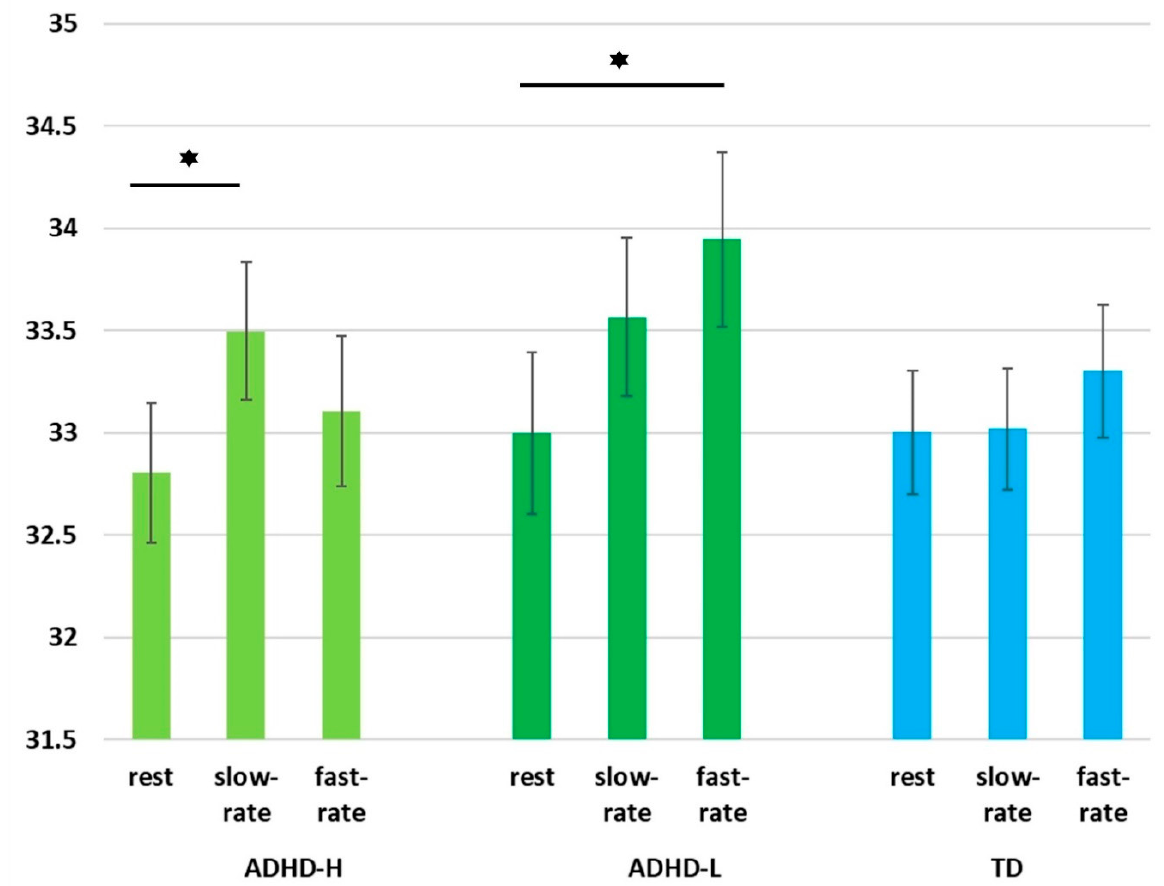
Figure 7. Relative delta power alterations among groups under three conditions (rest, slow-rate, and fast-rate task). * indicated significance, p <0.01